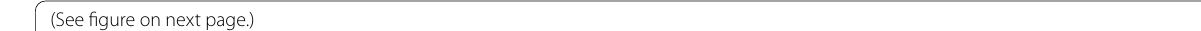
figure on next Fig. 8 Compositional variations of Grt ( a , b ), Wm ( c , d ) and Px ( e , f ) in garnet-bearing gneisses (ZR4) with density of chemical compositions (grey areas) obtained from Q-XRMA mineral analysis. a , b Large Grt1a grains has mostly Alm composition (Alm 70–80%, Py 10–20%), Grt1b still has Alm composition (Alm 70–80%) but with lower Py content (< 10%). Ca content increases in Grt2a and Grt2b (1.0–1.5 a.p.f.u.). c , d Wm1 is muscovite and Wm2 and Wm3 have phengite composition. e , f Cpx1 has X Jd content ≥